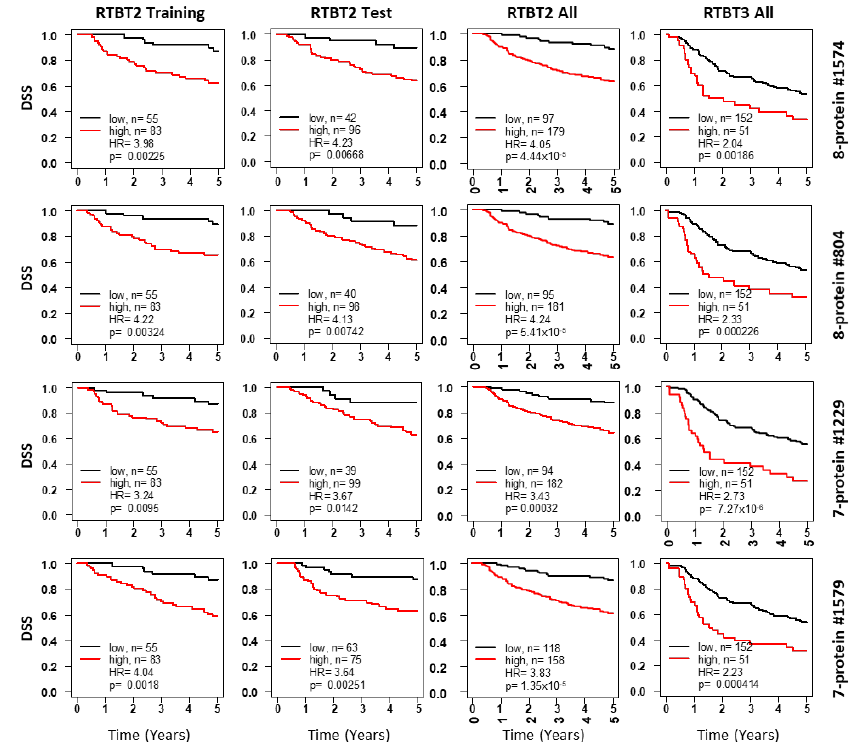
Figure 2. Kaplan-Meir curves for Ridge models developed with the RTBT2 dataset. Shown for each representative model are survival curves for the training subset (column 1), testing subset (column2), all RTBT2 dataset (column3) and validation in the RTBT3 dataset (column4). Patients in each training subset were divided into high (60%) versus low (40%) for survival comparison and the cutoff threshold was applied to the testing and the independent RTBT3 dataset.